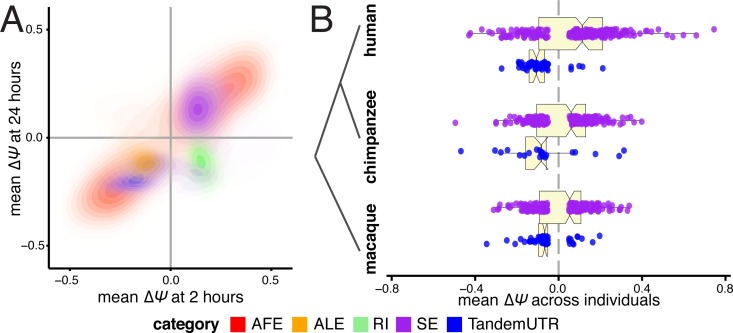
Directed shifts in RNA processing persist across time, stimulus conditions, and closely related species.(A) Correlations between ΔΨ values after 2 hours of infection (x-axis) and ΔΨ values after 24 hours of infection (y-axis), presented as density plots per RNA processing category in contrasting colors. Plotted are events that are significant after 2 hours of either Listeria or Salmonella infection. (B) Distributions of ΔΨ values for skipped exons (purple) and TandemUTRs (blue) following infection of whole blood cells with lipopolysaccharide, assessed in human (top), chimpanzee (middle) and rhesus macaque (bottom) individuals (N = 6 per species). We observe prominent global shifts in isoform distributions in human and macaque (SEhuman
P = 0.003, TandemUTRhuman
P = 2.4×10−13; SEmacaque
P = 0.05, TandemUTRmacaque
P = 8.8×10−6) with a more modest trend observed in chimpanzee, potentially due to poor transcript annotations in the chimpanzee genome (SEchimpanzee
P = 0.26, TandemUTRchimpanzee
P = 0.002). All p-values were calculated using a Student’s t-test testing deviation from a mean of zero.